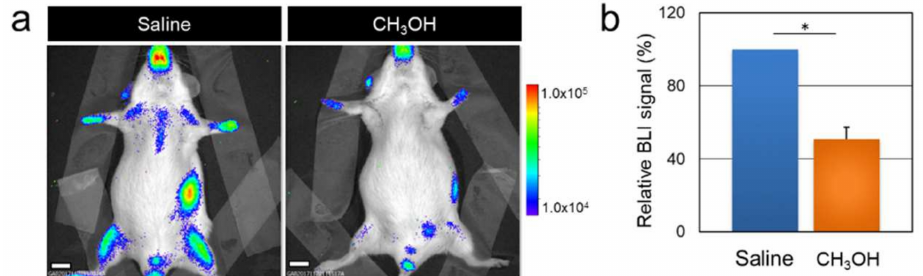
Figure 4. Effect of methanol administration on bioluminescent signal in MITO-Luc mice. Animals were administered either vehicle (saline) or methanol solution (CH 3 OH) and BLI was performed 10 days after administration. Panel ( a ) shows representative images of an animal per group. The color bar indicates the relative bioluminescent signal intensities in photons/s/cm 2 /sr. ( b ) Quantification of the BLI signal expressed as the relative percentage of the saline group. The asterisk (*) indicates a significant difference as assessed by a two-tailed Student t -test for unpaired data ( p <